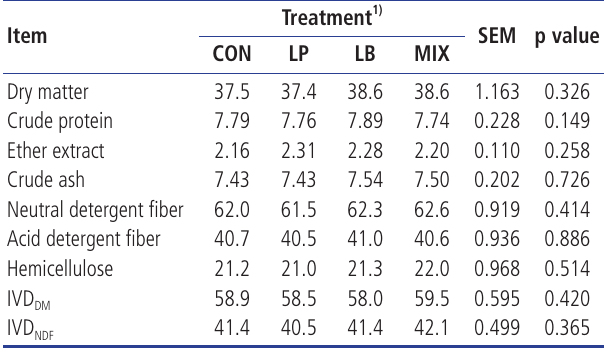
Table 3. Effects of homo and hetero fermentative inoculants on chemical compositions and in vitro digestibility of sweet potato vine mixed with Italian ryegrass hay ensiled for 100 days (%, dry matter)